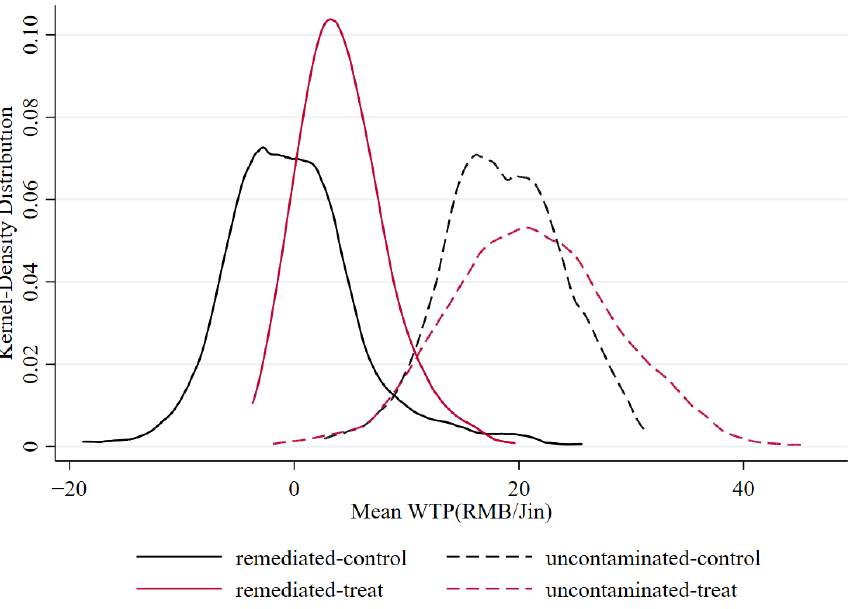
Figure 4. Distribution of WTP with and without information.